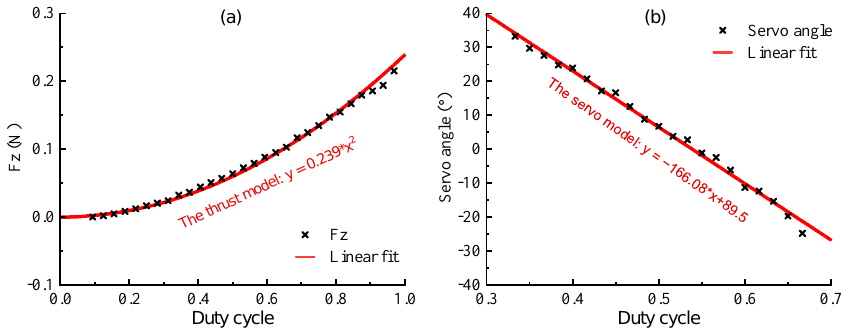
Figure 5. The actuator model. ( a ) The thrust model. ( b ) The servo